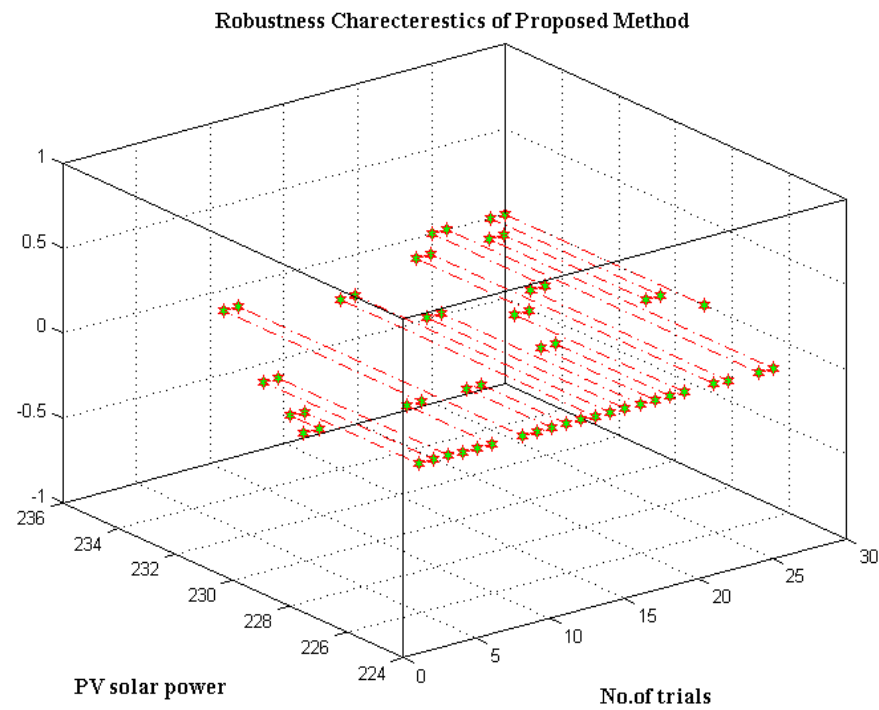
Figure 15. Robustness